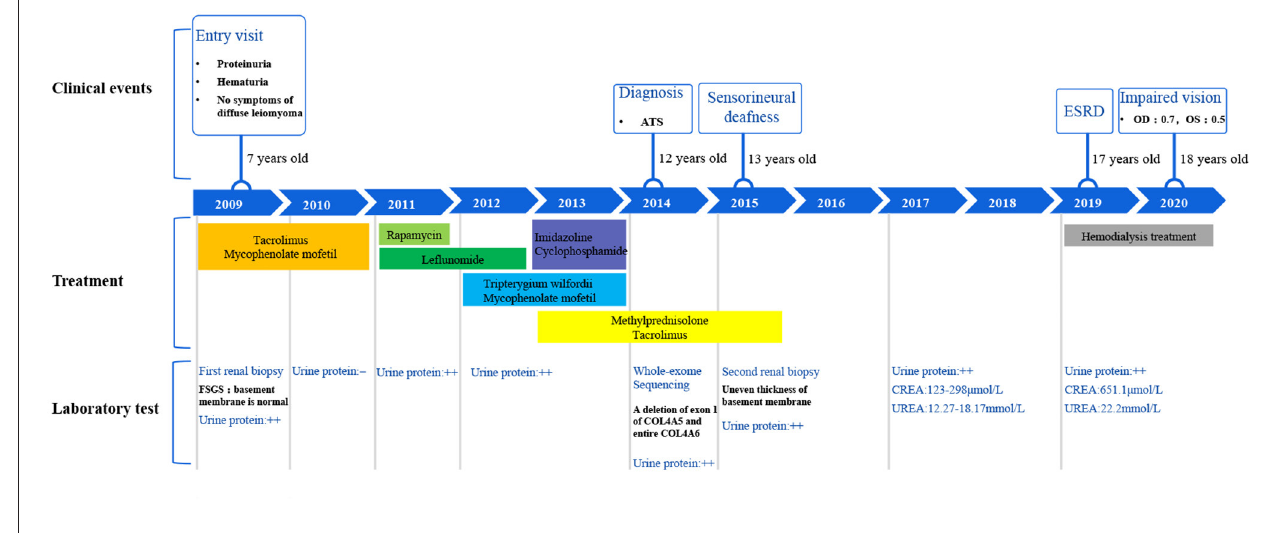
FIGURE 2 | Disease progression of the proband.